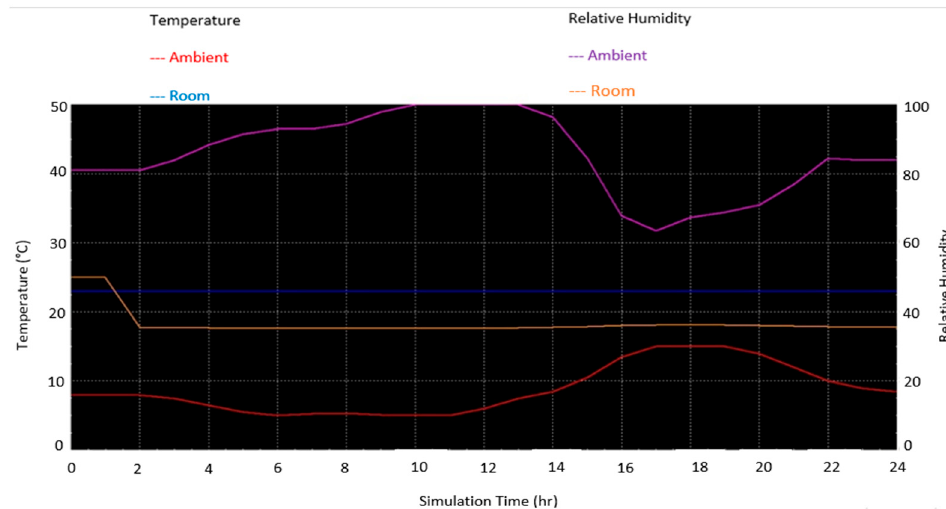
Figure 8. 1st January simulation run for option A.